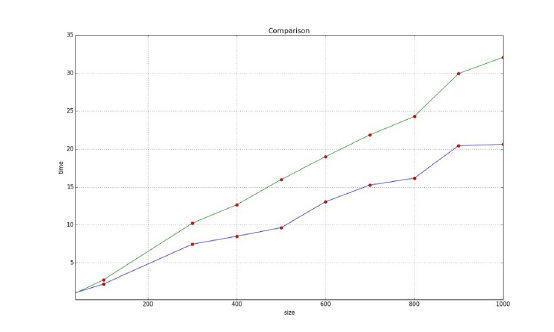
Figure 5. Comparison of calculation results with large amount of